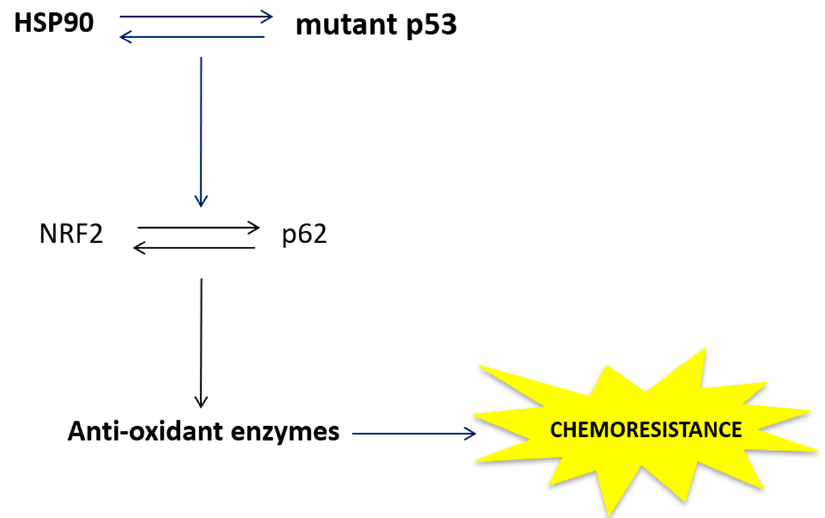
Figure 8. Schematic model describing how the cross-talk between mutant p53 and HSP90 and NRF2 / p62 activates the antioxidant response to promote chemoresistance. Such cross-talk was promoted by Apigenin in PaCa44 cells while inhibited in Panc1 cells. Heat shock protein 90 (HSP90); nuclear factor erythroid 2 like 2 (NRF2).